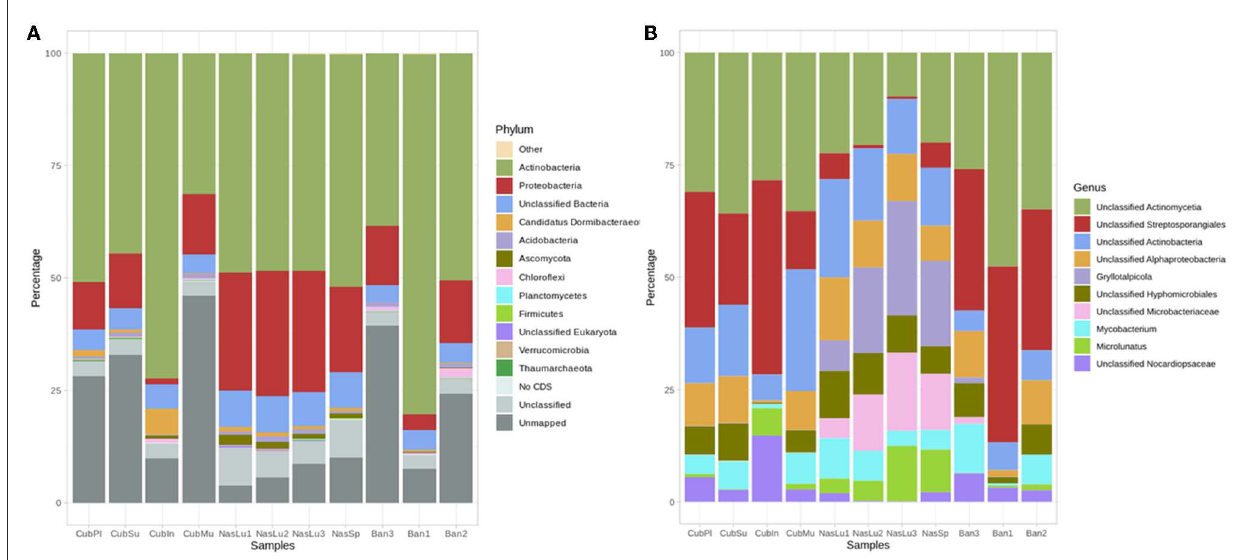
FIGURE7 Taxonomic representations obtained through SqueezeMeta pipeline. (A) Taxonomic representation at the phylum level. (B) Taxonomic representation at the genus level, belonging to the subset “aromatic_aa” (phenylalanine, tyrosine, and tryptophan biosynthesis). Percentages were calculated through SQMtools after SqueezeMeta